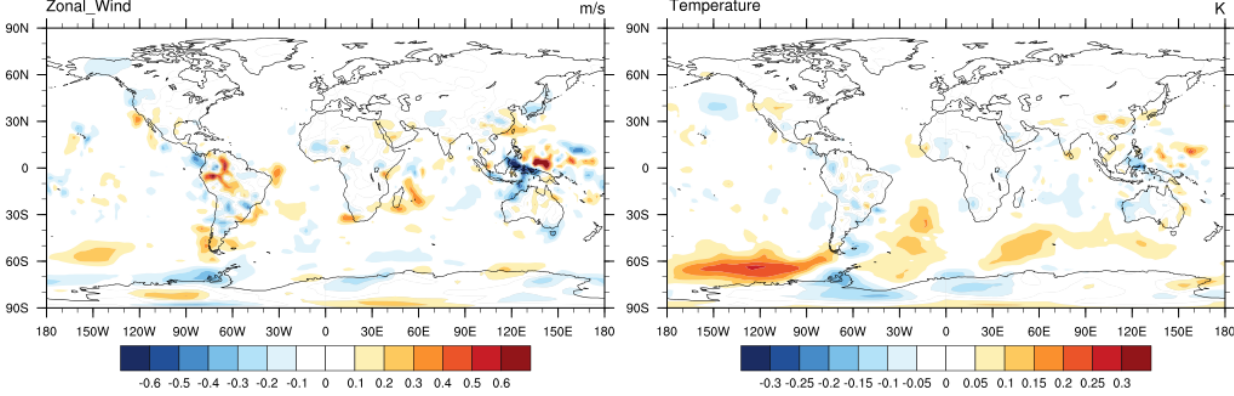
Figure 8. Difference of horizontal analysis increment of U (left, unit: ms − 1 ) and T (right, unit: K) between CTRL_SONDE and EXP_RO at the level of 100hPa for a 2-week analysis from 15 November